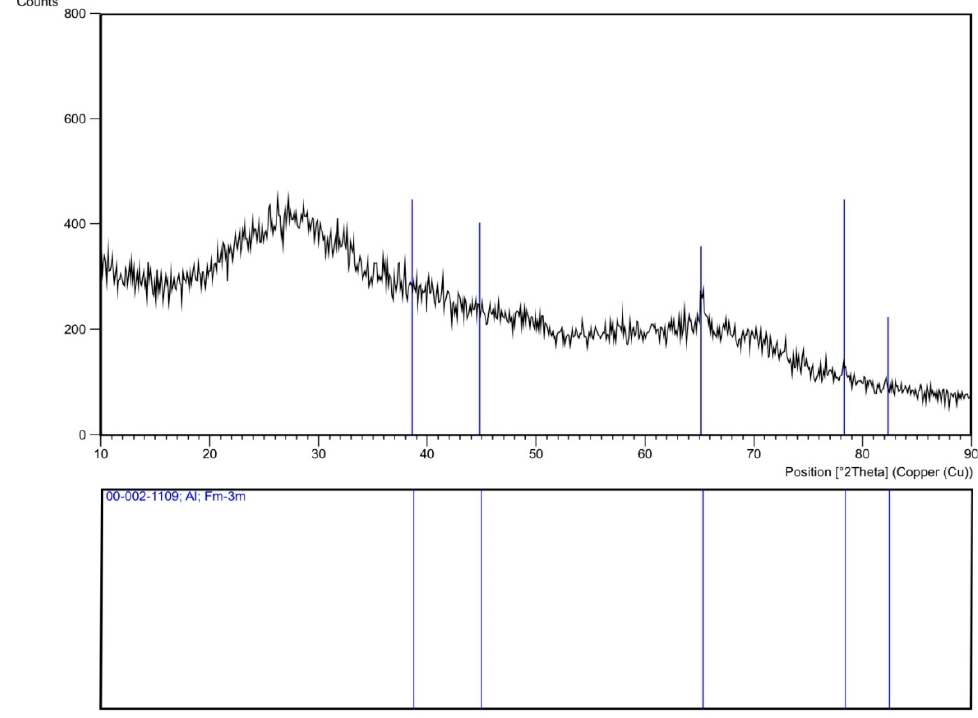
Figure 7. GIXD diffraction pattern for the angle of incidence α = 0.50° obtained for the 02K sample subjected to thermo-chemical treatment in sodium sulphate solution.